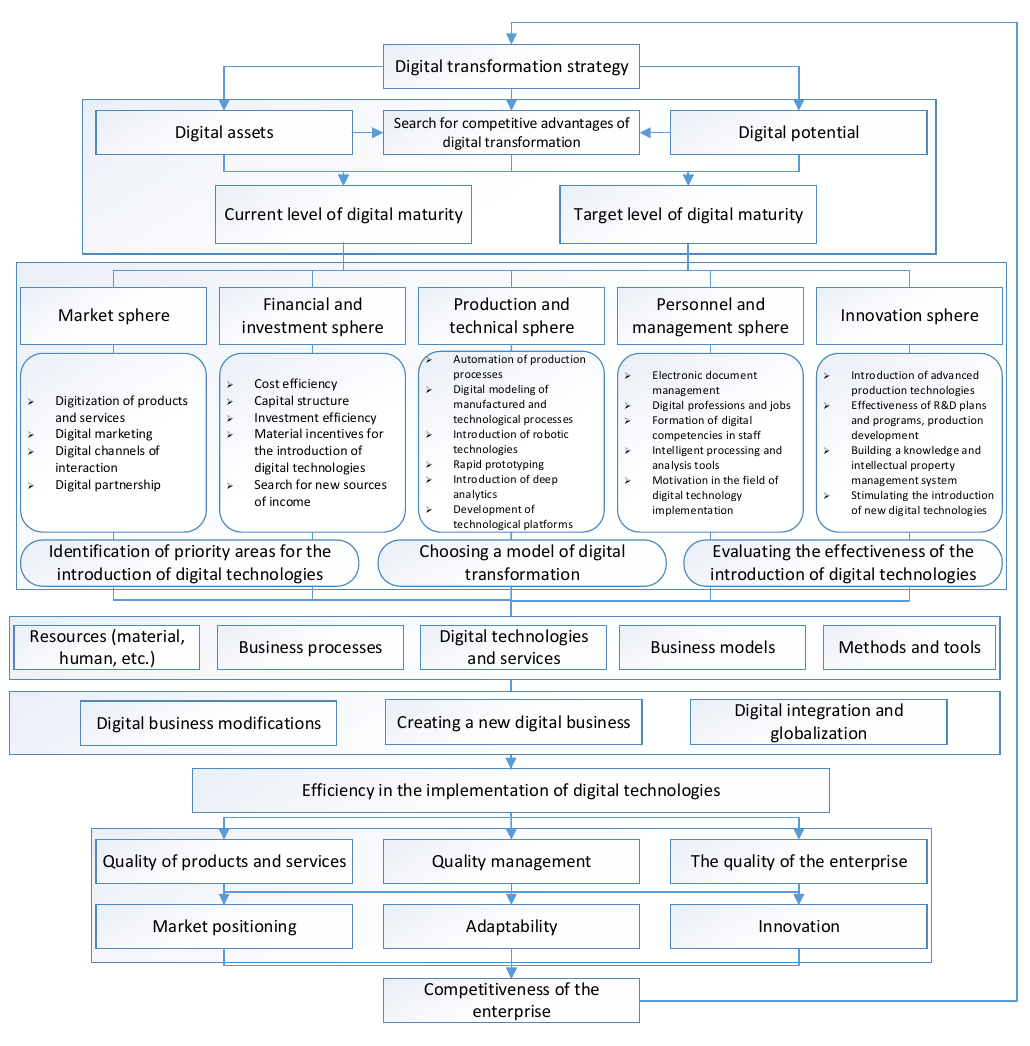
Figure 4. Conceptual model of enterprise competitiveness formation in the process of digital trans- formation. Source: own study.